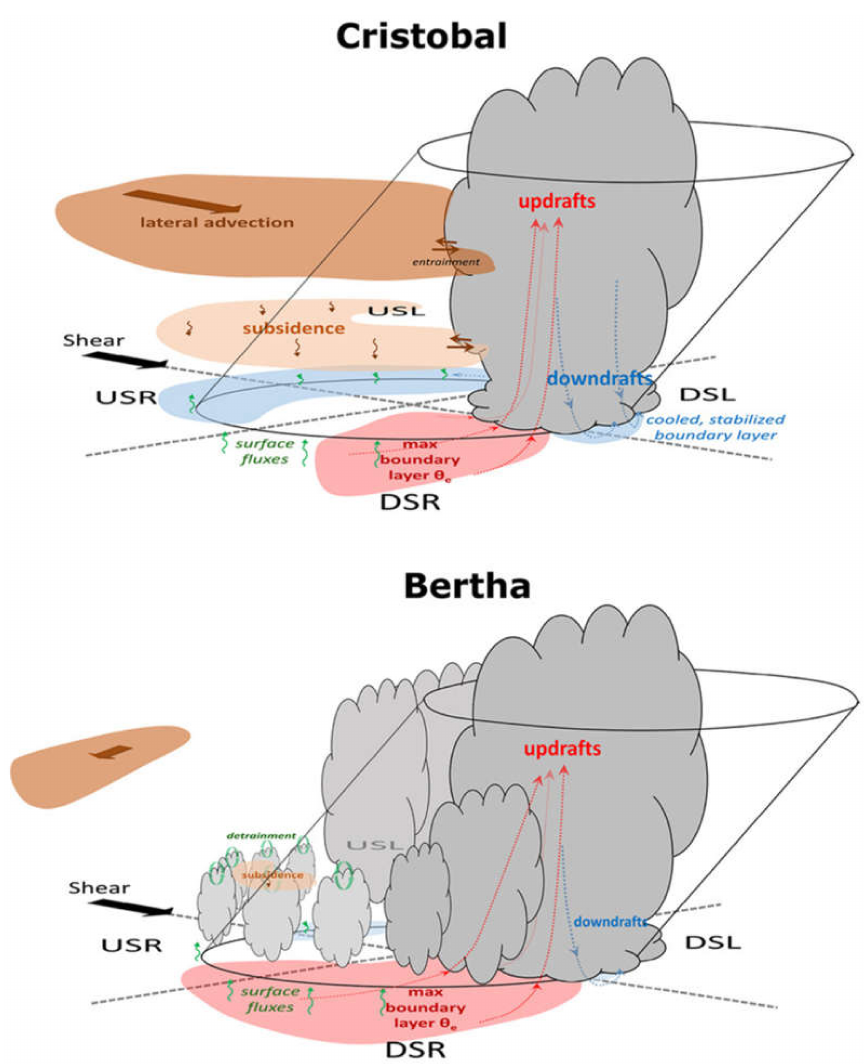
Figure 7. Three-dimensional schematics summarizing the hypothesized hindrances to precipitation symmetry intropical cyclones. The top schematic depicts the more asymmetric case (Cristobal), while the bottomschematic depicts the more symmetric case (Bertha). Adapted from